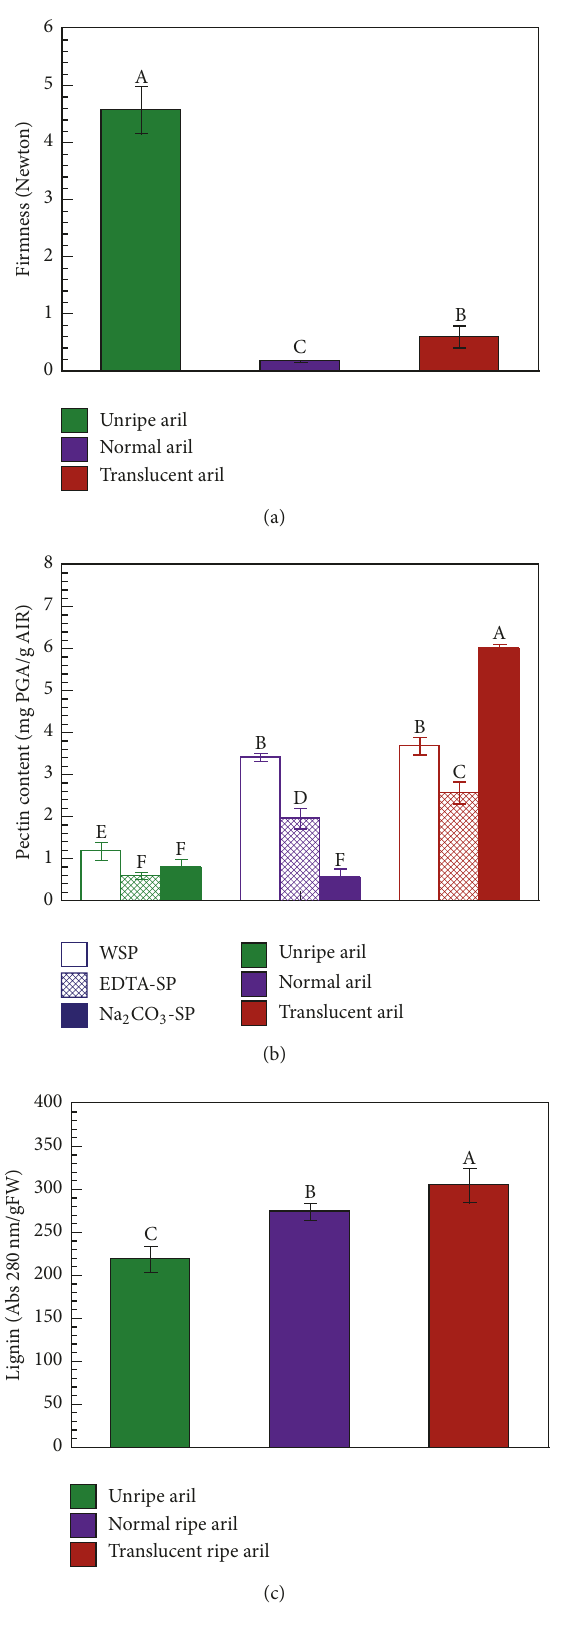
Figure 4: Mangosteen firmness (a), pectin distributed fractions (b), and lignin content (c). Values were mean ± SD ( 𝑛 = 4